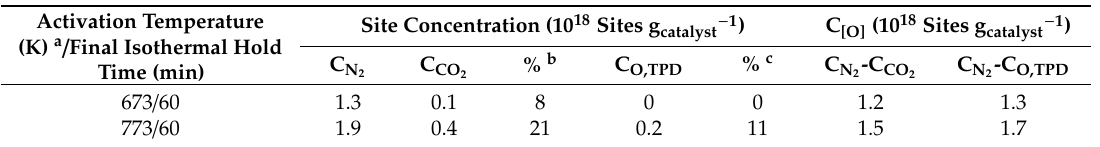
, C CO and C O,TPD ) and 2 2